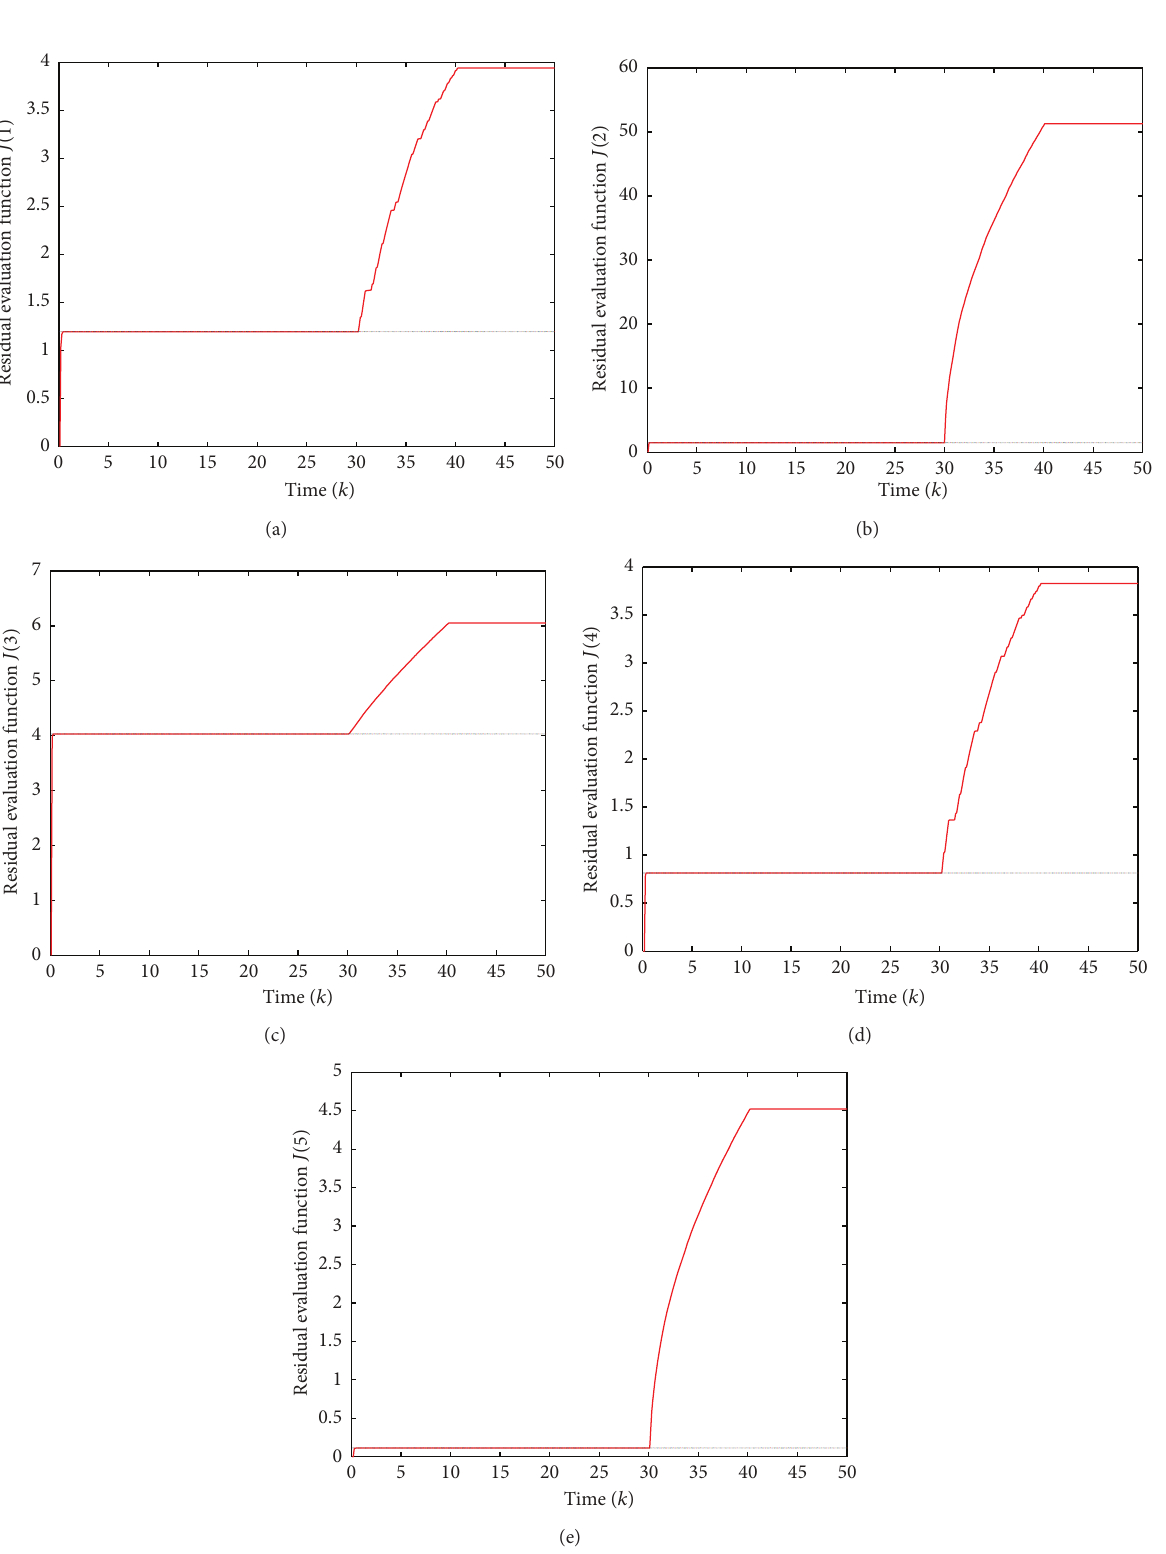
Figure 2: System residual evaluation